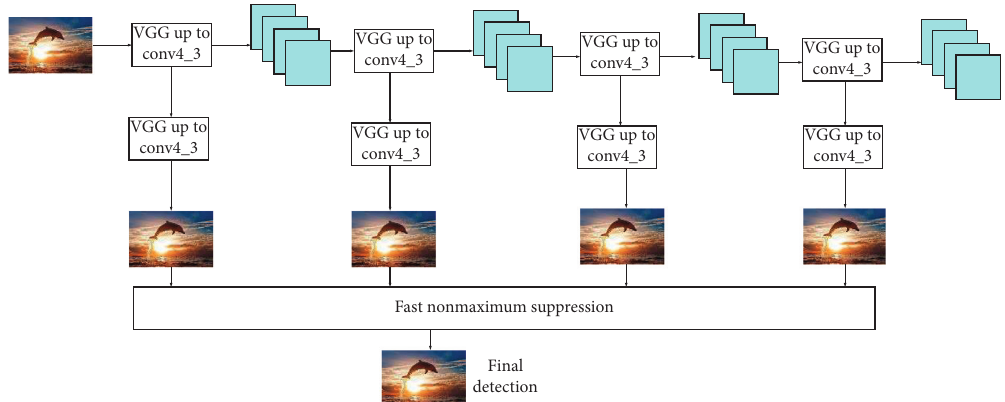
Figure 3: SSD target real-time detection